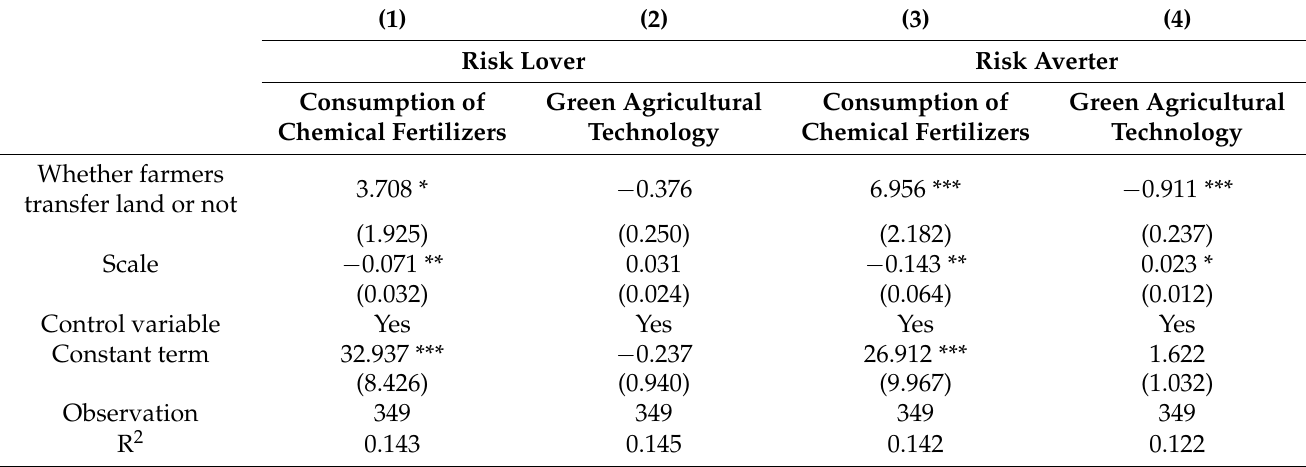
Table 4. Land transfer and farmers’ green production behavior: difference in risk preferences.